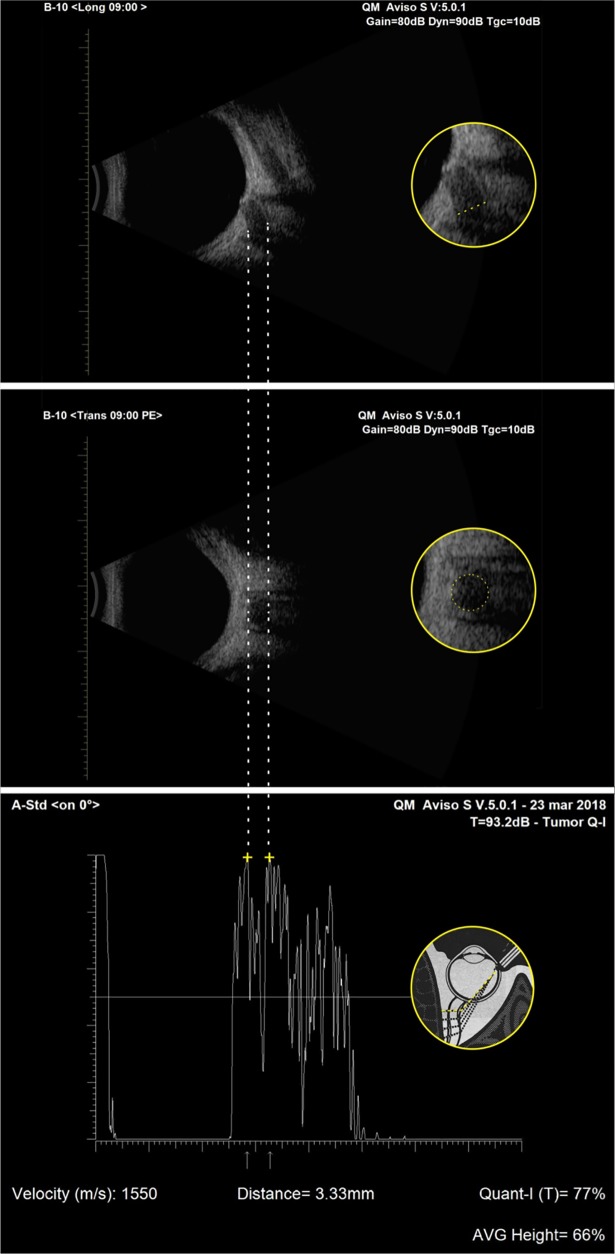
Longitudinal (top) and transverse (middle) B-scan echograms of the optic nerve confirm that the sound beam of A-scan probe is perpendicular to the surface of the anterior third of the optic nerve (yellow dashed line) (bottom).